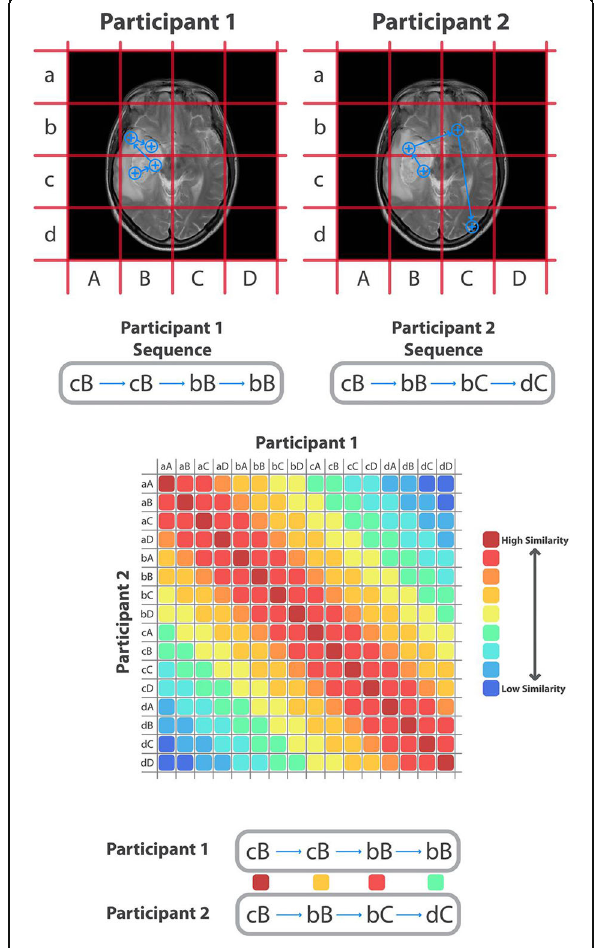
Fig. 2 Simplified details of the ScanMatch method used to calculate similarity in scanning patterns. The top panel shows the fixations of two participants overlaid on an example stimulus. A grid-based region-of-interest (ROI) mask is also overlaid with a combination of lower- and upper-case letters used to define each ROI. The middle panel demonstrates the generation of letter sequences used to describe each participants ’ search behaviour and the substitution matrix that provides information on the relationship between two ROIs. The bottom panel shows how two participants scanning behaviour are compared. The colour-coded substitution matrix is used to calculate an alignment score which indexes how similar two participants ’ scanning behaviour is. Red squares indicate a high score because the two participants fixated in the same ROI whereas blue squares indicate a low score because the two participants fixated in different ROIs. Alignment scores are then normalised to generate a score between 0 (low similarity) to 1 (high similarity). See Cristino et al. (2010) for a full description of the ScanMatch